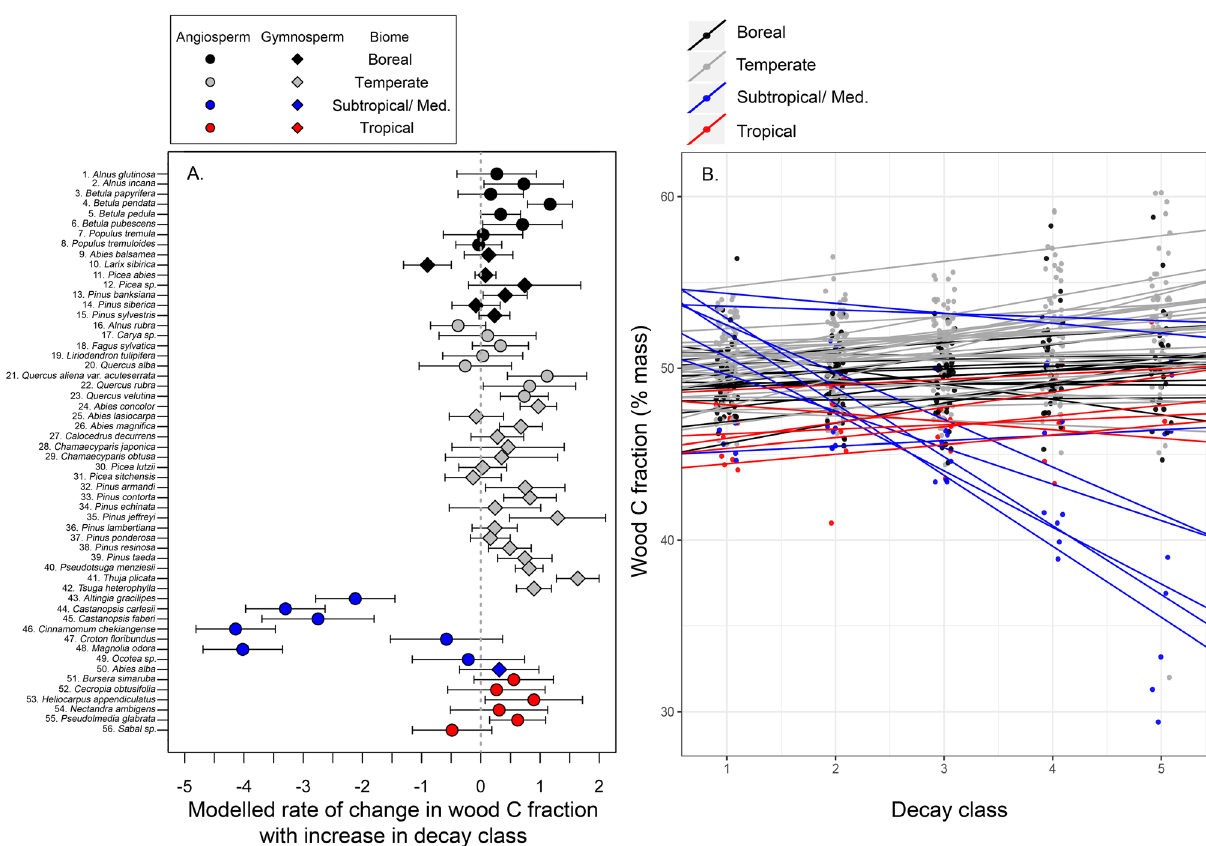
Fig. 3 Changes in dead wood carbon fractions (CF) as a function of wood decomposition stage. Panel A presents modeled rates of change in dead wood CFs as a function of decay class, which are the slope estimates obtained from a mixed-effects model (±s.e.). Panel B presents the species-speci fi c models predicting dead wood CFs as a function of decay